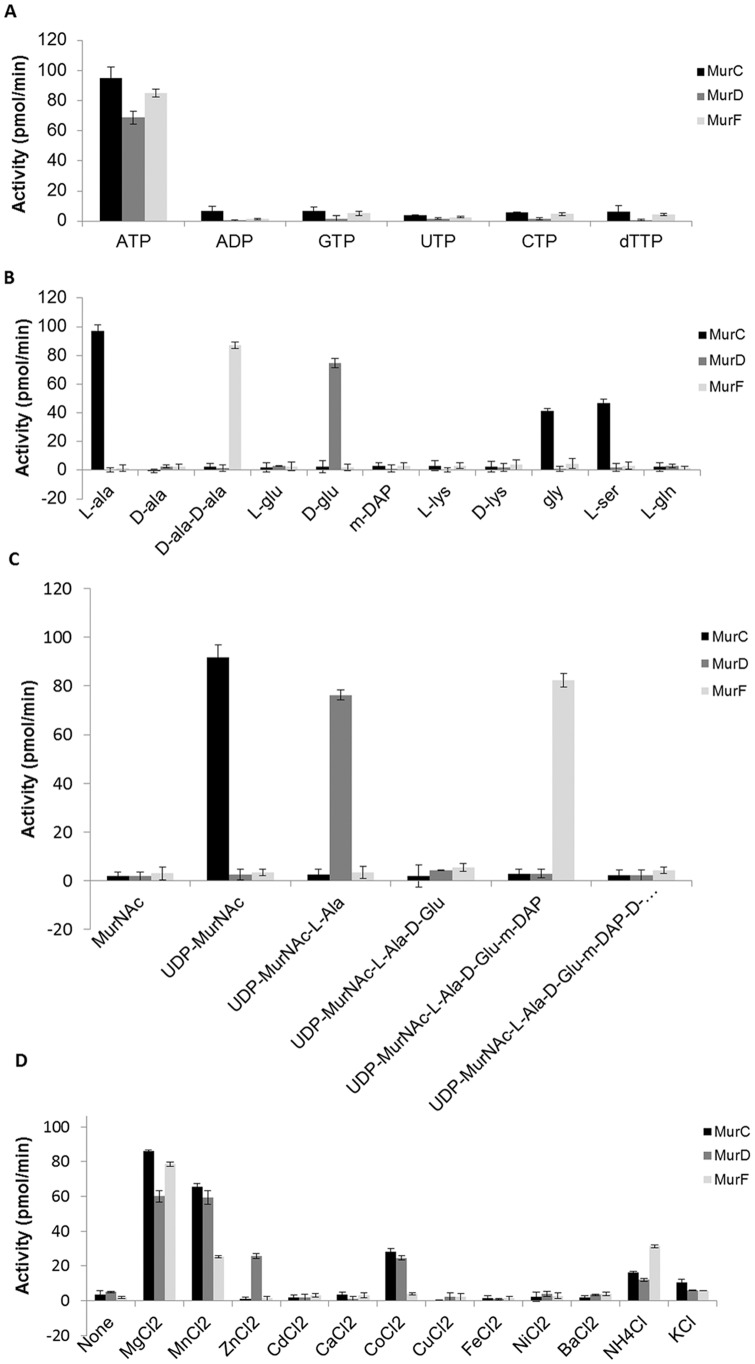
Determination of substrate specificities of Mur synthetases.Different (A) Nucleotides (B) Amino acids (C) Uridine sugars and (D) divalent and monovalent cations (at 5 mM concentration) were tested to analyze their specificities for MurC, MurD and MurF synthetases. X-axis represents different substrates used. Y-axis, in all the cases, represents the amount of Pi released in pmol/min.